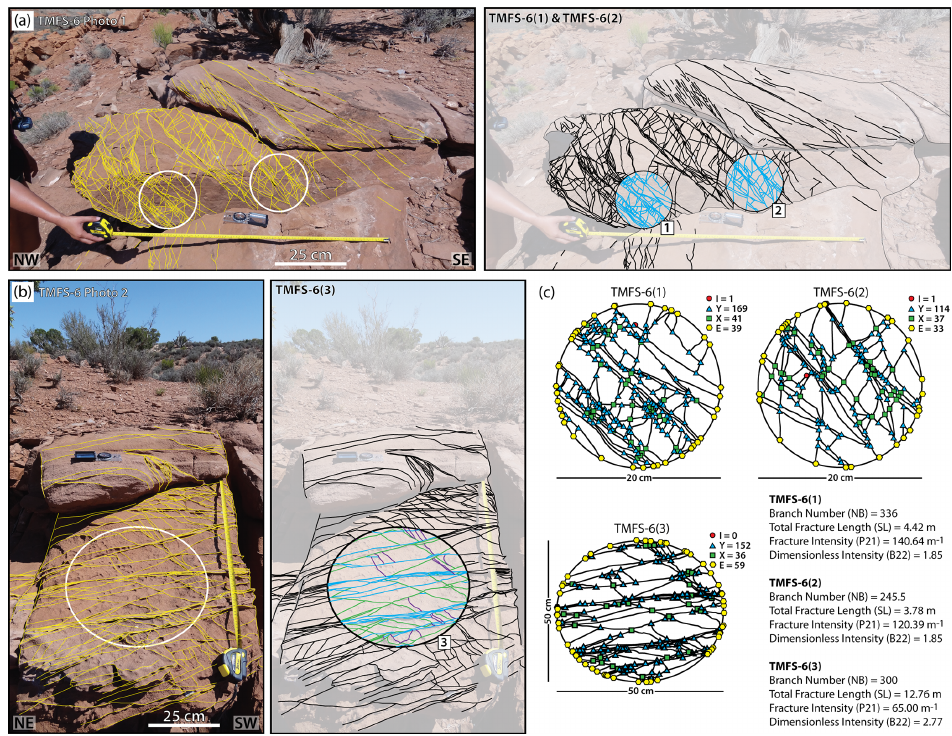
Figure A6. Sample station TMFS-6 scan circles (a, b) and nodal analysis (c) with statistics.